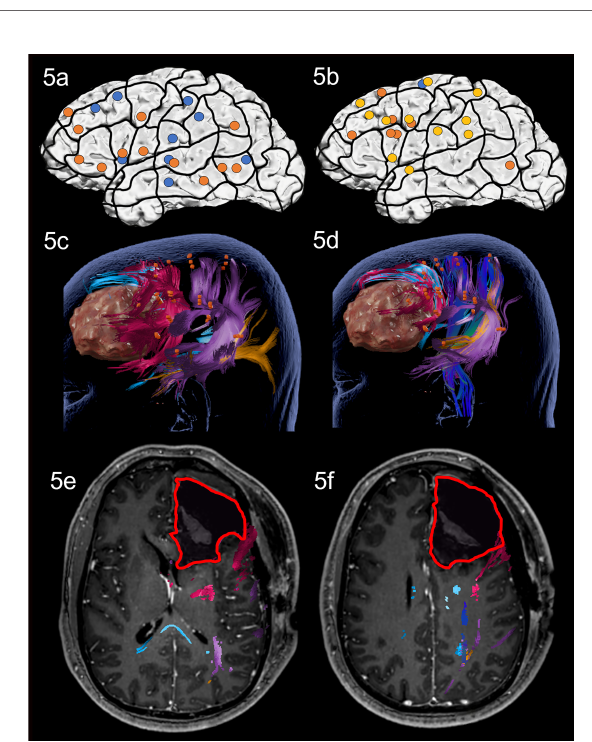
FIGURE 6 | Case 6. Left panels show ON results, right panels AN results. Panels (A, B) nTMS stimulation sites that induced errors; no response and hesitations in orange, semantic errors in yellow and performance errors in blue. Panels (C, D) Fiber tracking results including the lesion, nTMS cortical endpoints in orange and color-coded tracts with CNT in in direction-coded, here dark blue, AF in purple, SLF in pink, ILF in yellow, and CF in light blue. Panels (E, F) Screenshot of intraoperative positive cortical sites with tags 1-3 on the middle and posterior STG and tag 4 on the posterior MTG for ON, and tags 11-13 on the middle and posterior STG for AN. Panels (G, H) Overlap of tracking and postoperative T1-weighted imaging after elastic fusion with the resection cavity marked in red.